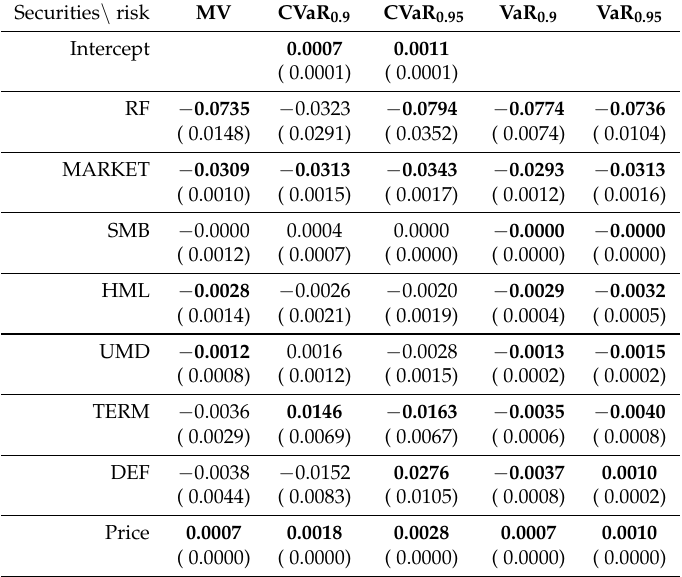
Table 5. Hedging of Dividend Yield. The table reports the estimates and their corresponding bootstrap errors (based on 400 bootstrap replications) for different risk measures (mean-variance MV, conditional value-at-risk CVaR, and value-at-risk VaR). The bold font represents statistical significance (at the 5% nominal level) of individual coefficients except for the last row where the bold font signifies a statistically different price from E ( y ) .